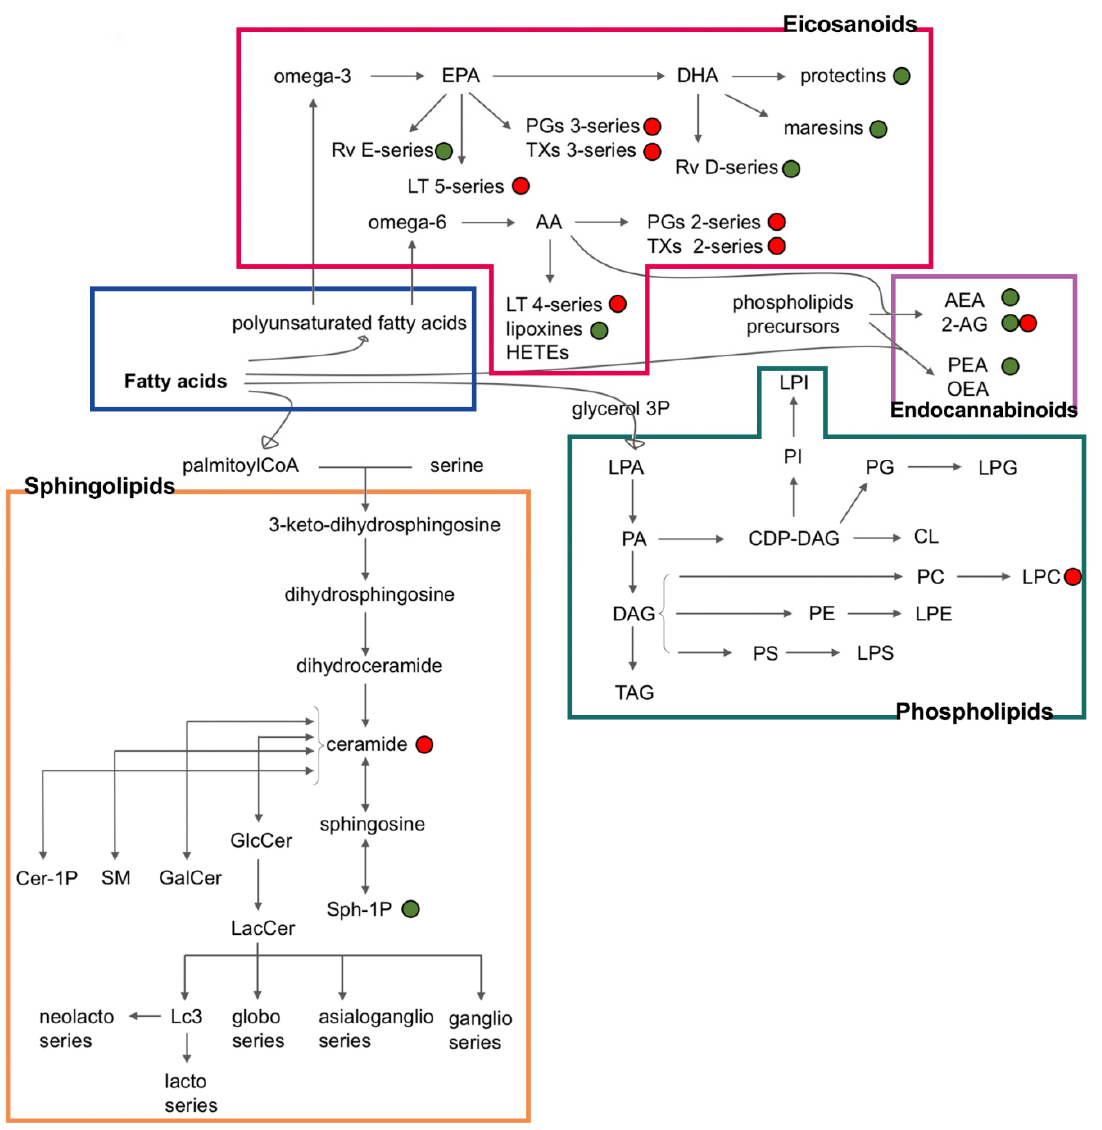
Figure 1. Inflammatory lipids and their interconnections. The green points indicate lipids with anti-inflammatory properties, whereas the red points indicate lipids with pro-inflammatory properties [5–37]. FA: fatty acids and their derivatives; PUFA: polyunsaturated fatty acids containing